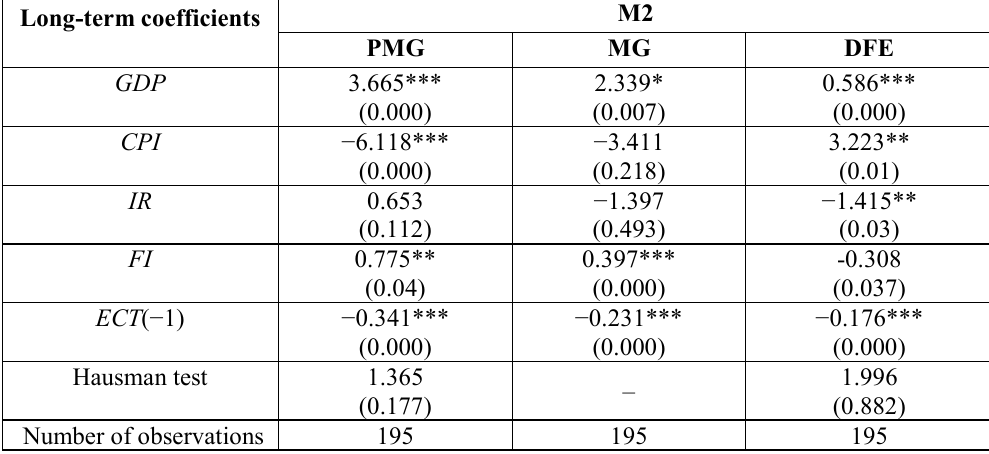
Table 4 . Results of Modelling for Broad Money M2 on the Dynamic Panel Data Long-term coefficients